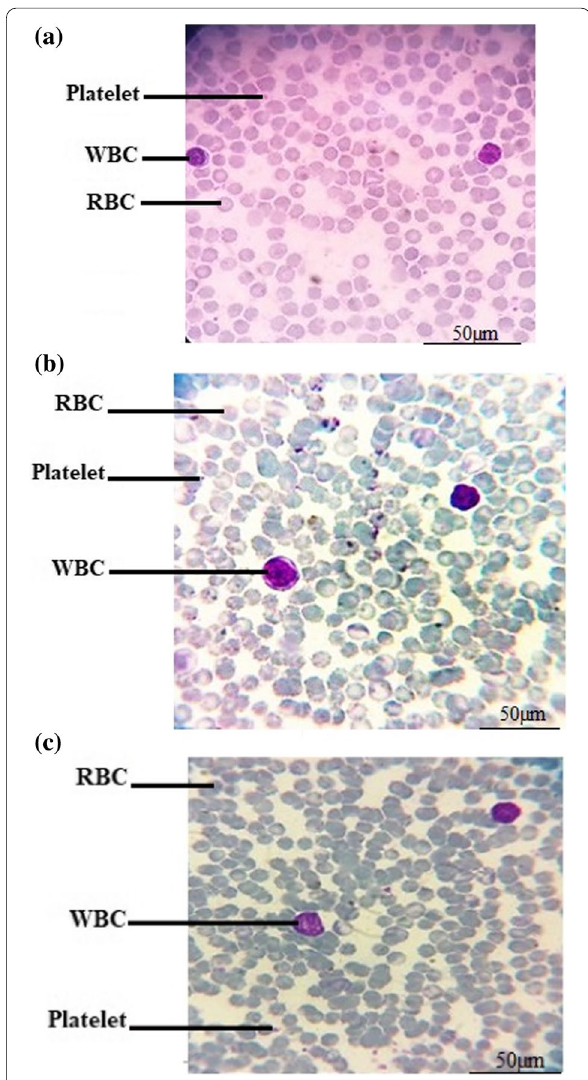
Fig. 4 Microscopic photographs taken from blood parameters of rats, a the group taking phycocyanin, b the group taking AgNp – phycocyanin, c control group